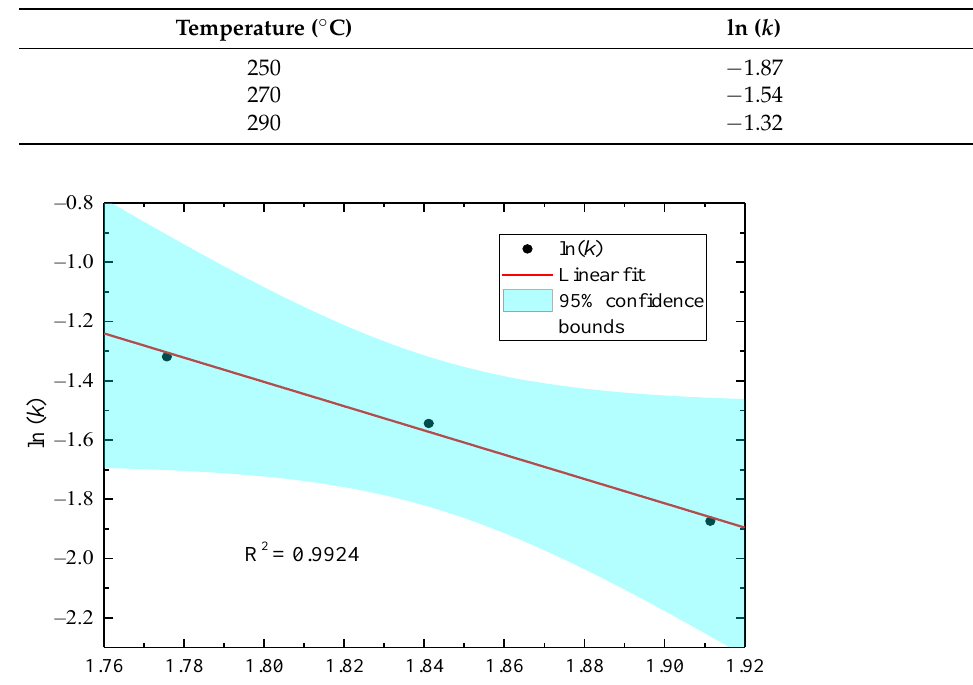
Table 3. Determined values of ln( k ).